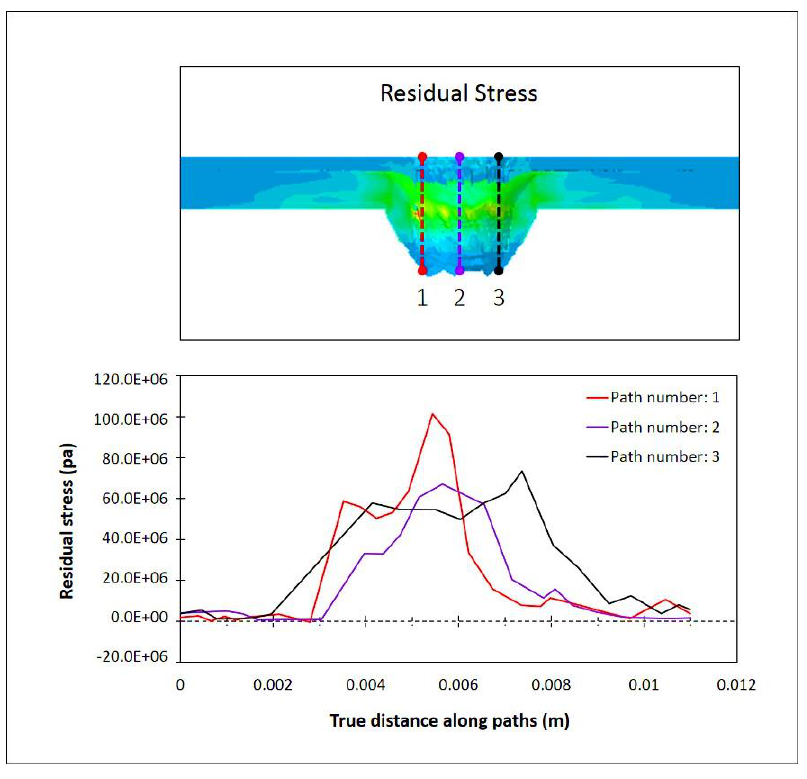
Figure 28. Residual stress distribution throughout the formed-bush region, and along the three paths.